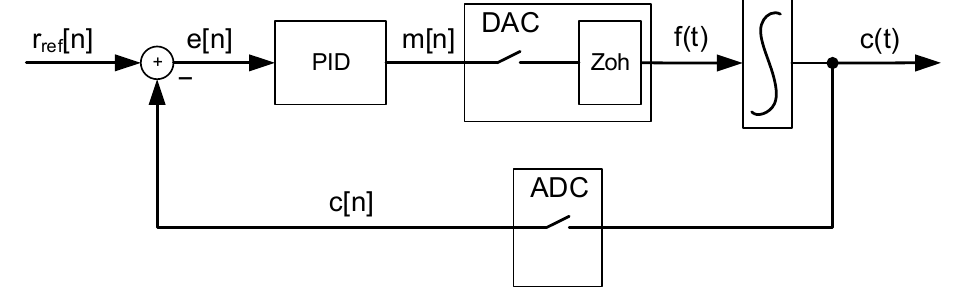
Figure 14. Control loop with PID and data converters.